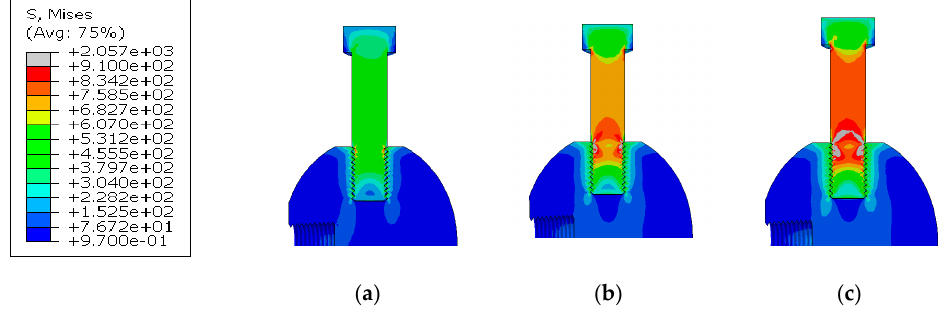
Figure 16. Stress diagrams of the bolt-sphere connection: ( a ) initial loading; ( b ) mid-term loading; ( c ) postloading.